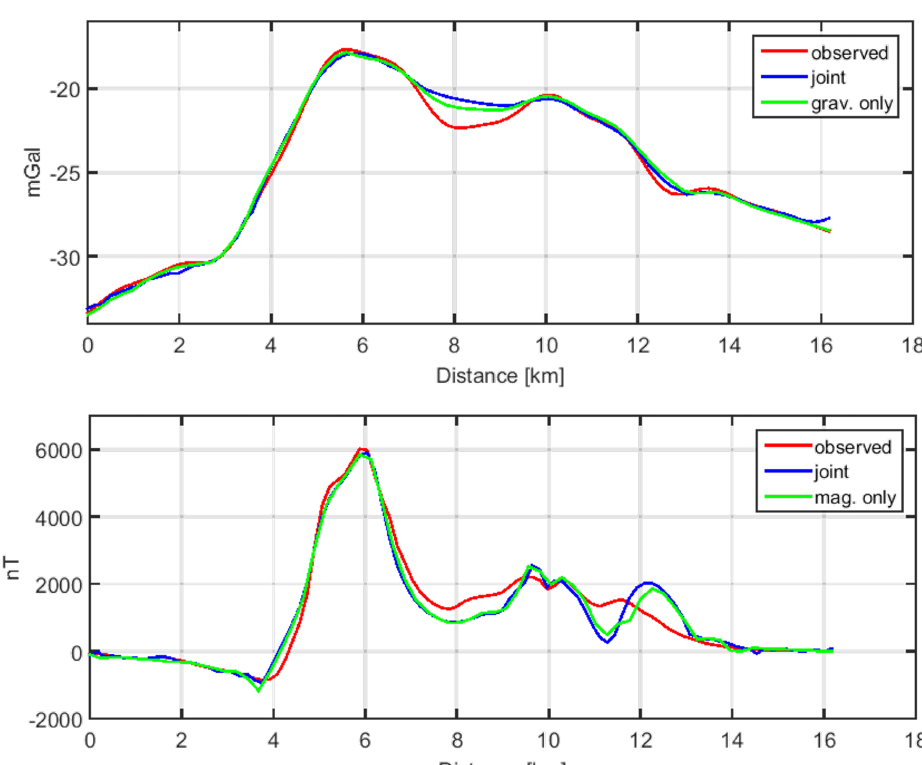
Figure 9. Predicted gravity and magnetic signal from gravity-only, magnetic-only and joint gravity and magnetic inversions.